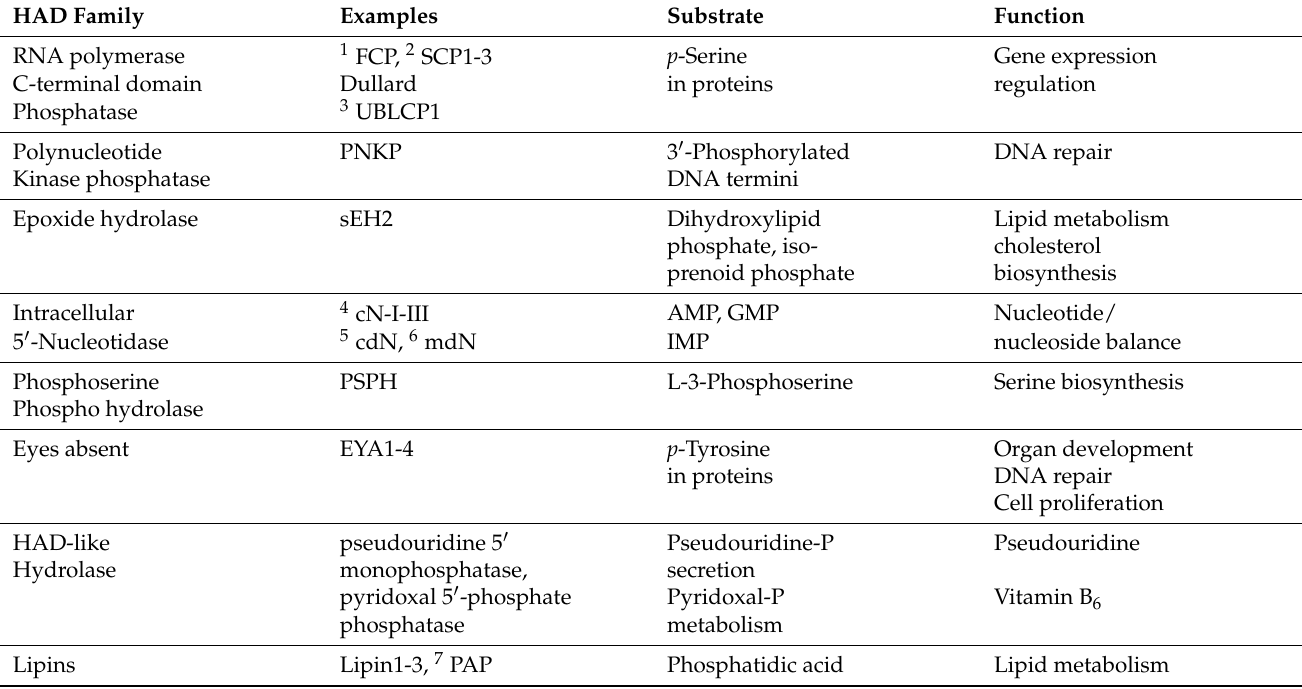
Table 2. The HAD family of